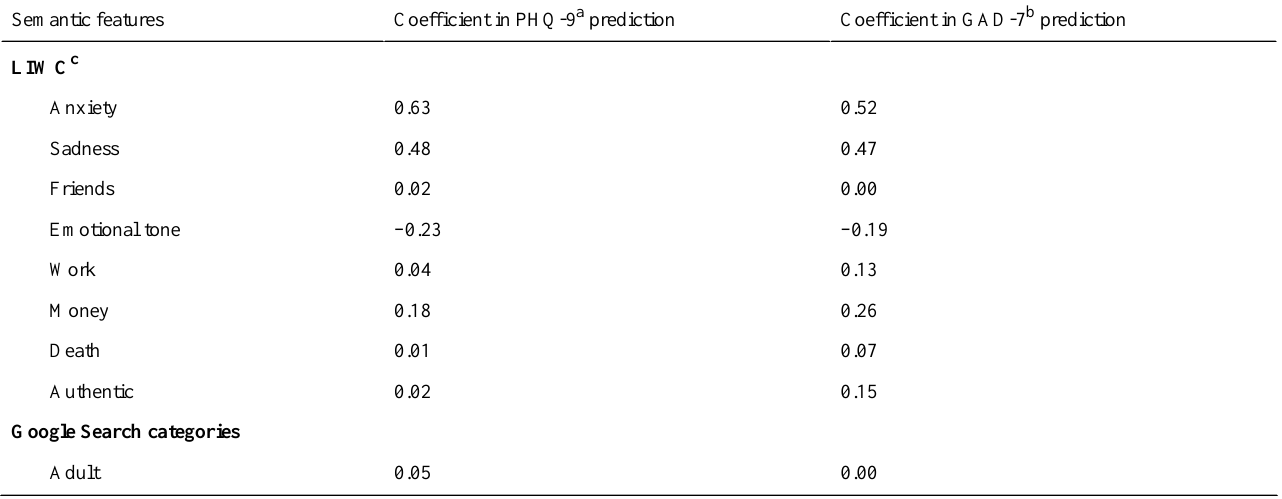
Table 7. The coefficients of 9 semantic features in lasso